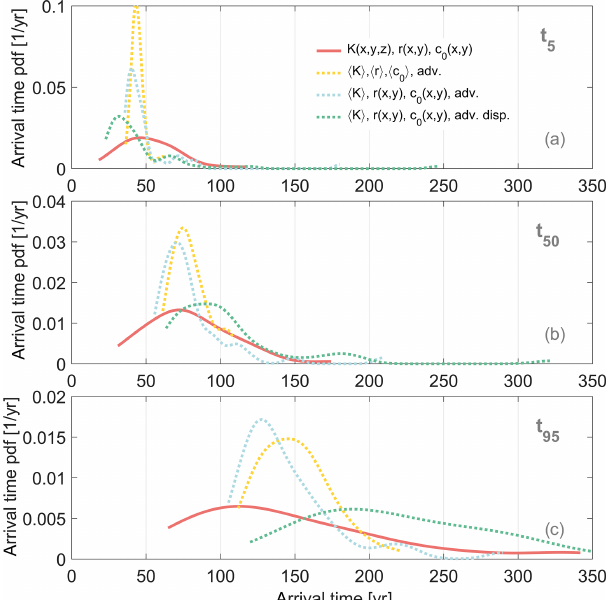
Figure 7. Probability density function of the time required for 5% (a) , 50% (b) , and 95% (c) of the total recorded mass to reach a well considering a heterogeneous K field, heterogeneous r and het- erogeneous c 0 (reference case, red solid line); an upscaled K value, averaged r and averaged c 0 accounting for advection only (yellow dashed line); an upscaled K value, heterogeneous r and heteroge- neous c 0 accounting for advection only (blue dashed line); an up- scaled K value, heterogeneous r and heterogeneous c 0 accounting for advection and dispersion (green dashed